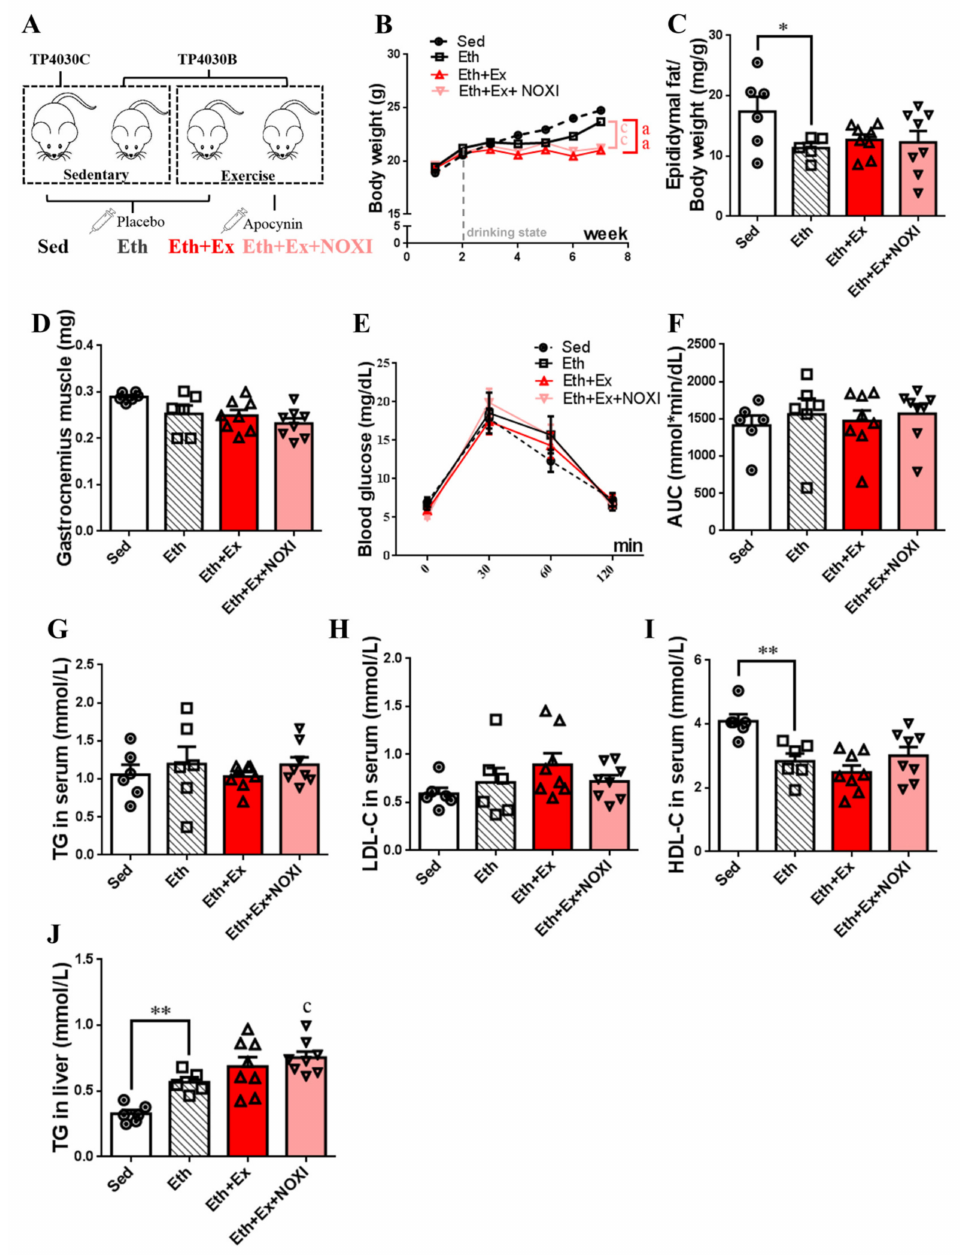
Figure 4. Drinking alcohol during exercise aggravates dyslipidemia, which had no significant effect after apocynin intervention. ( A ) Grouping of experimental animals. ( B ) Changes in body weight over 7 weeks. ( C ) Ratio of epididymal fat to body weight. ( D ) Gastrocnemius muscle weight. ( E , F ) Glucose change and area-under-the-curve in glucose tolerance test. ( G , J ) TG content in serum and liver tissue. ( H ) The level of LDL-C in serum. ( I ) The level of HDL-C in serum. ( A – J ) Sed group, n = 6; Eth group, n = 6; Eth + Ex group, n = 8; Eth + Ex + NOXI, n = 8. The molding effect is represented by *, * p < 0.05 and ** p < 0.01. The exercise effect is denoted by a, aa p < 0.01. The effect of combined exercise and drug intervention is indicated by c, c p < 0.05 and cc p <